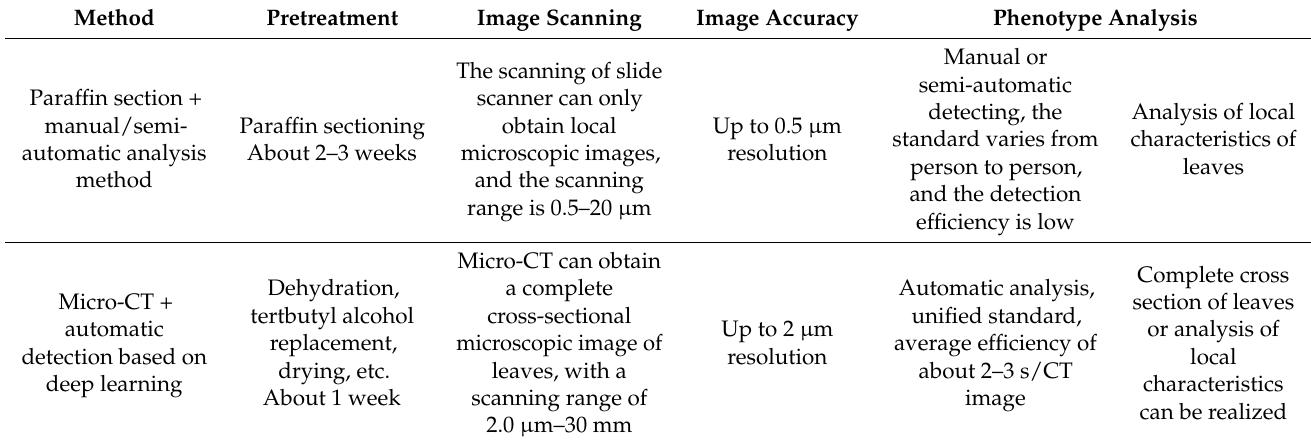
Table 1. Comparison of leaf microscopic image acquisition and analysis methods.